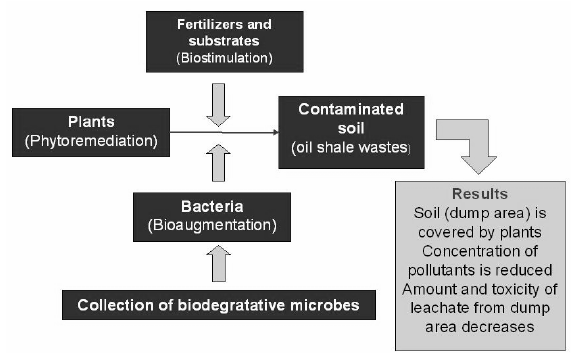
Fig 1. Principal scheme of technological approach for remediation of oil-shale chemical industry solid waste dump